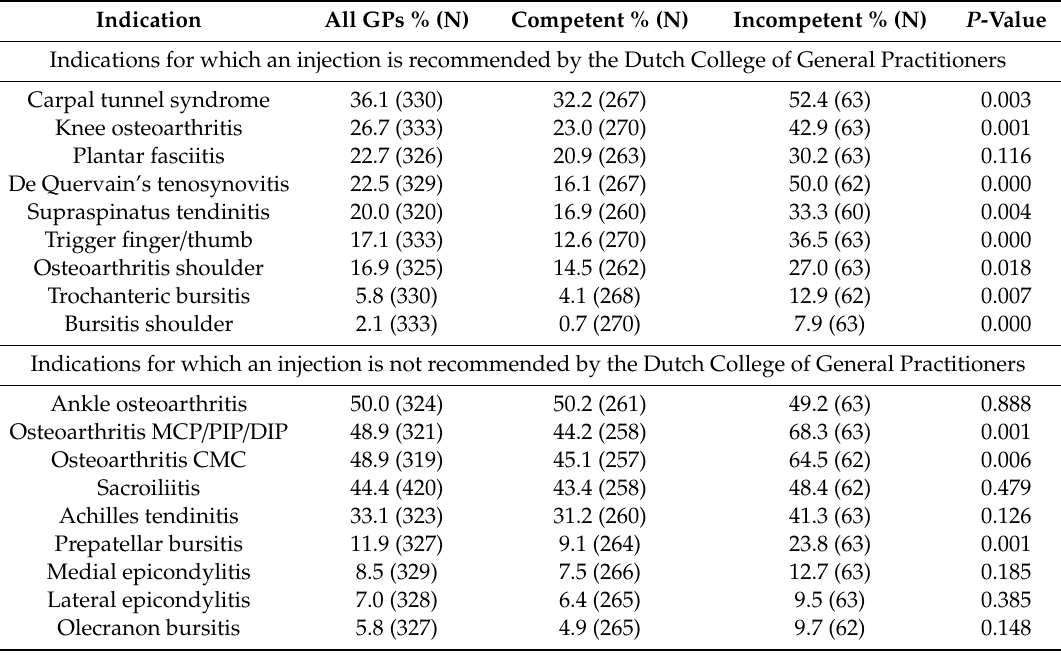
Table 2. Percentages of general practitioners (GPs) who referred an injection to secondary care per